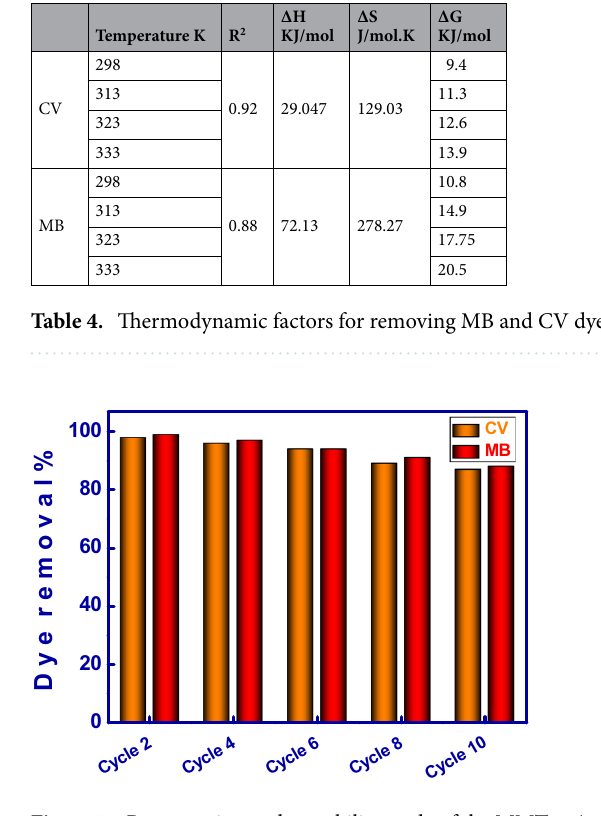
Figure 7. Regeneration and reusability study of the MMT-mAmCs to remove MB and CV